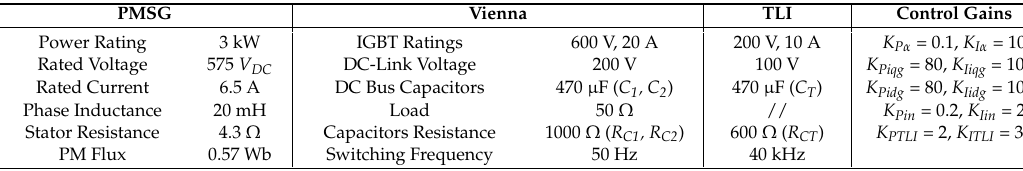
Table 3. System Table 3. System parameters.